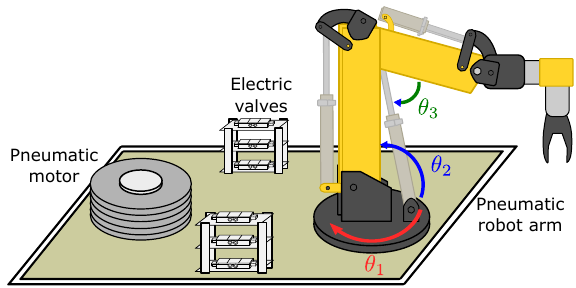
Figure 1. Pneumatic robot prototype with 6 DoF.